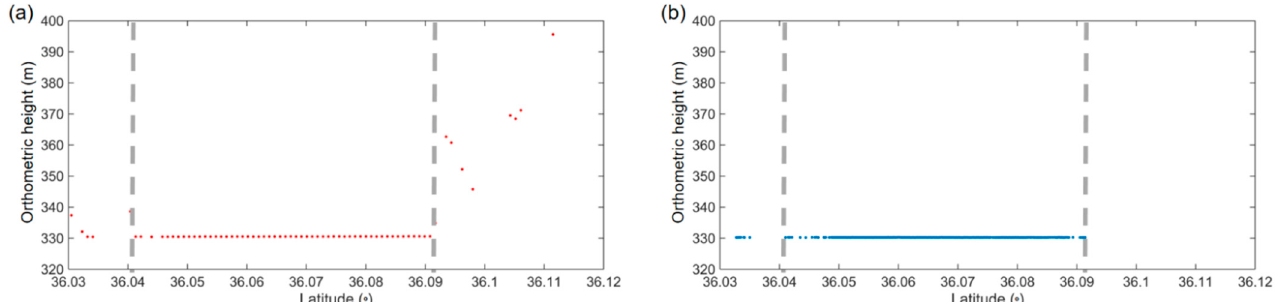
Figure 5. Comparisons of along-track surface heights across Mead Lake (i.e., the first lake in Figure 6) from ATL08 product ( a ) and ATL13 product ( b ). The vertical dash lines correspond to the water/land boundary of Lake Mead. It should be noted that the ellipsoidal heights from the ATL08 products were transformed into the orthometric heights to make them comparable.